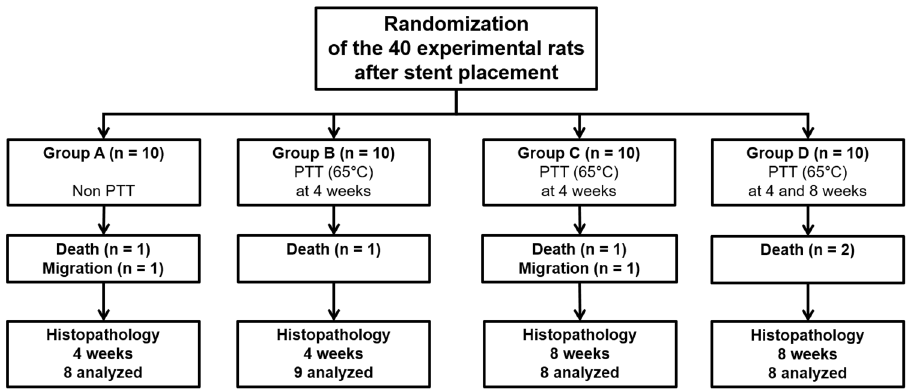
Figure 2. Flow diagram showing the randomization process and study follow-ups. Note. PTT; photothermal